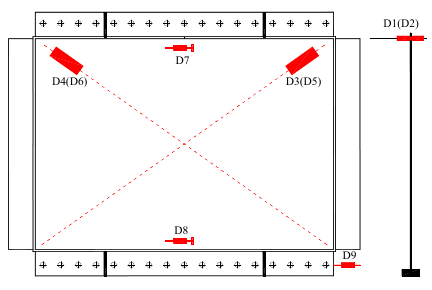
Figure 3. The test setup.